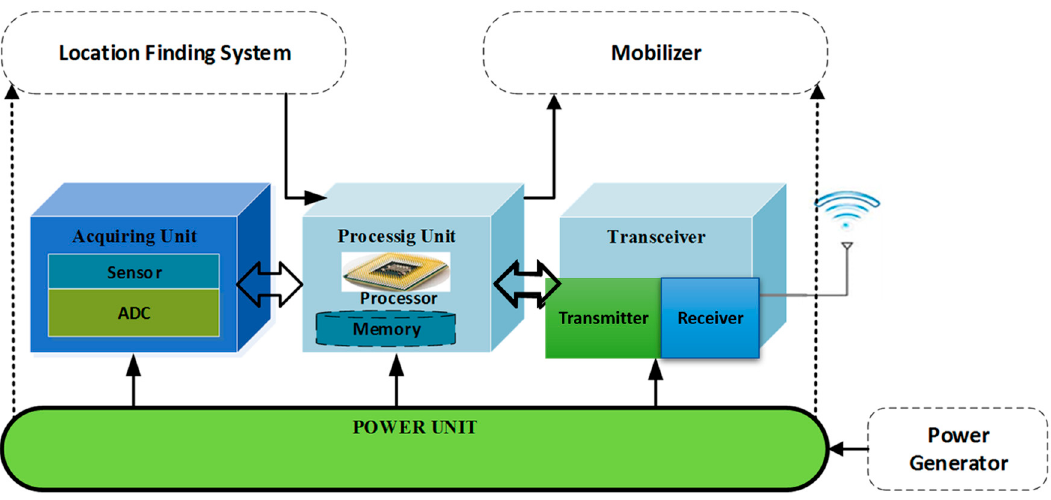
Figure 2. Components of a sensor node.